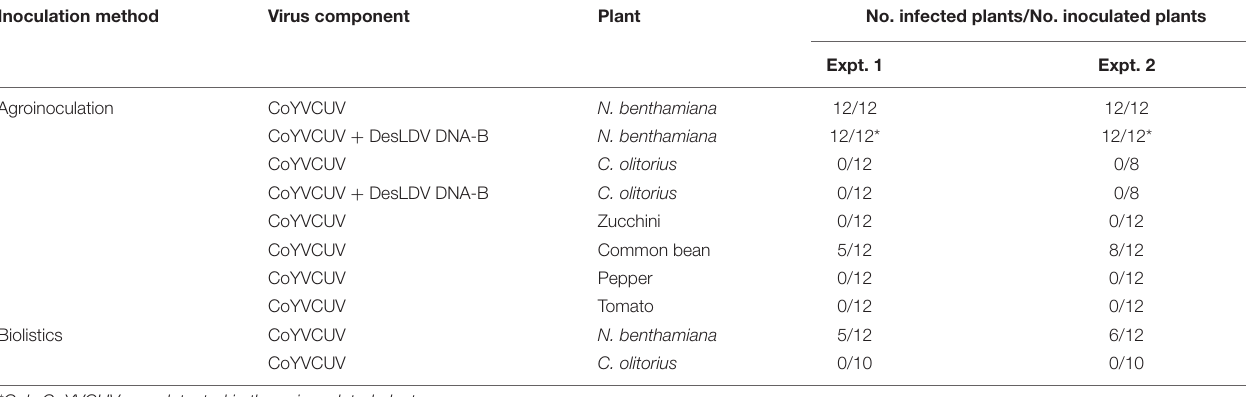
TABLE 4 | Infectivity of CoYVCUV in several plant species.